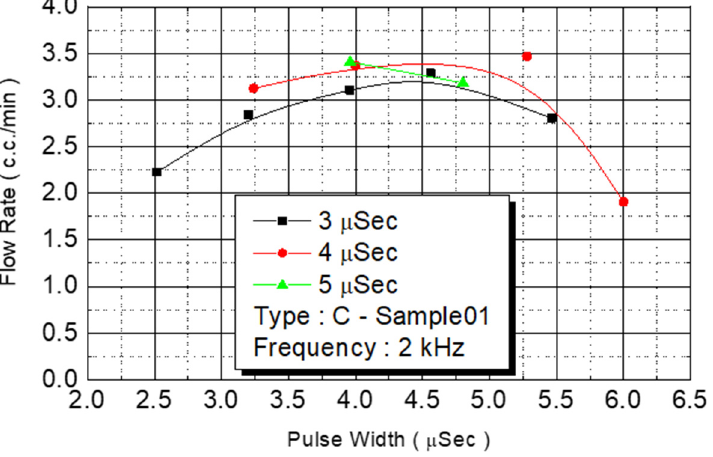
Figure 13. B1-00 flow test.